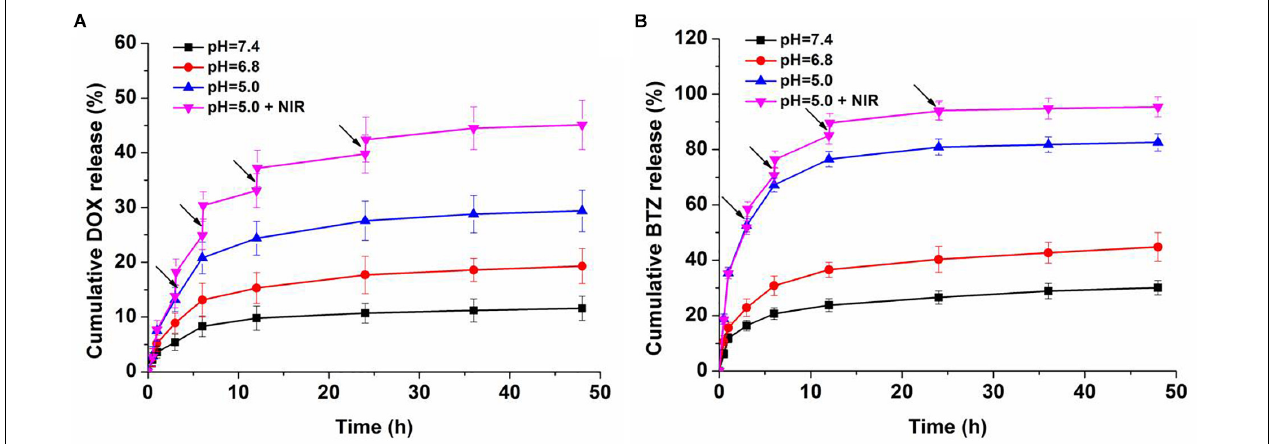
FIGURE 6 | In vitro (A) DOX and (B) BTZ release profile of dual-drug-loaded BP-DOX@PDA-PEOz-BTZ in release medium with different pH values of 7.4, 6.8, and 5.0, the arrows show NIR irradiation for 0.1 h.